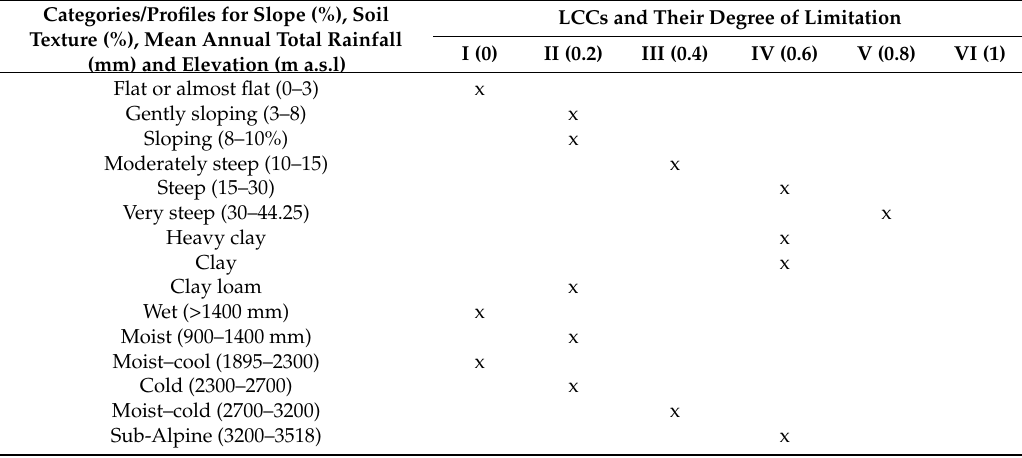
Table 1. Land capability classes (LCCs) and their degree of limitation. Categories/Profiles for Slope (%), Soil Texture (%), Mean Annual Total Rainfall (mm) and Elevation (m